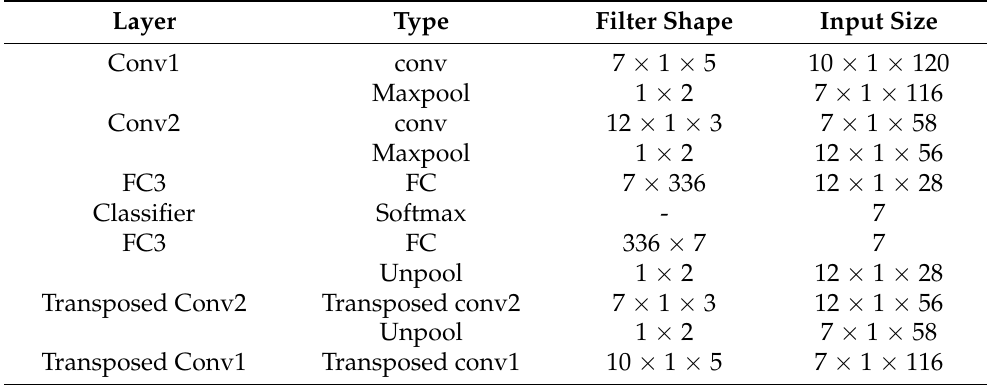
Table 3. Structural parameters of the odor labeling convolutional